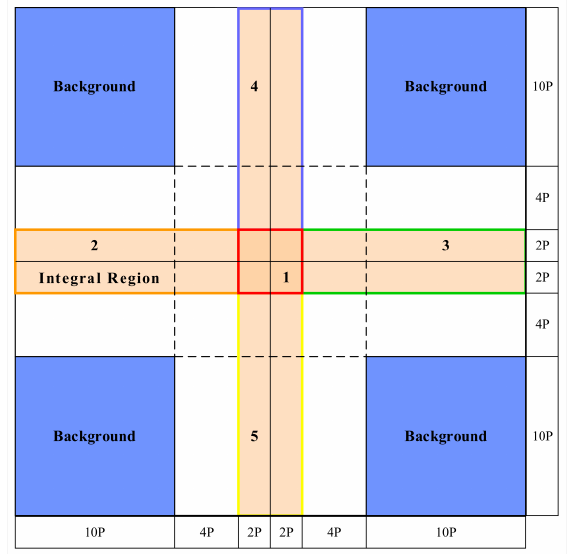
Figure 6. Schematic of the point target response integration